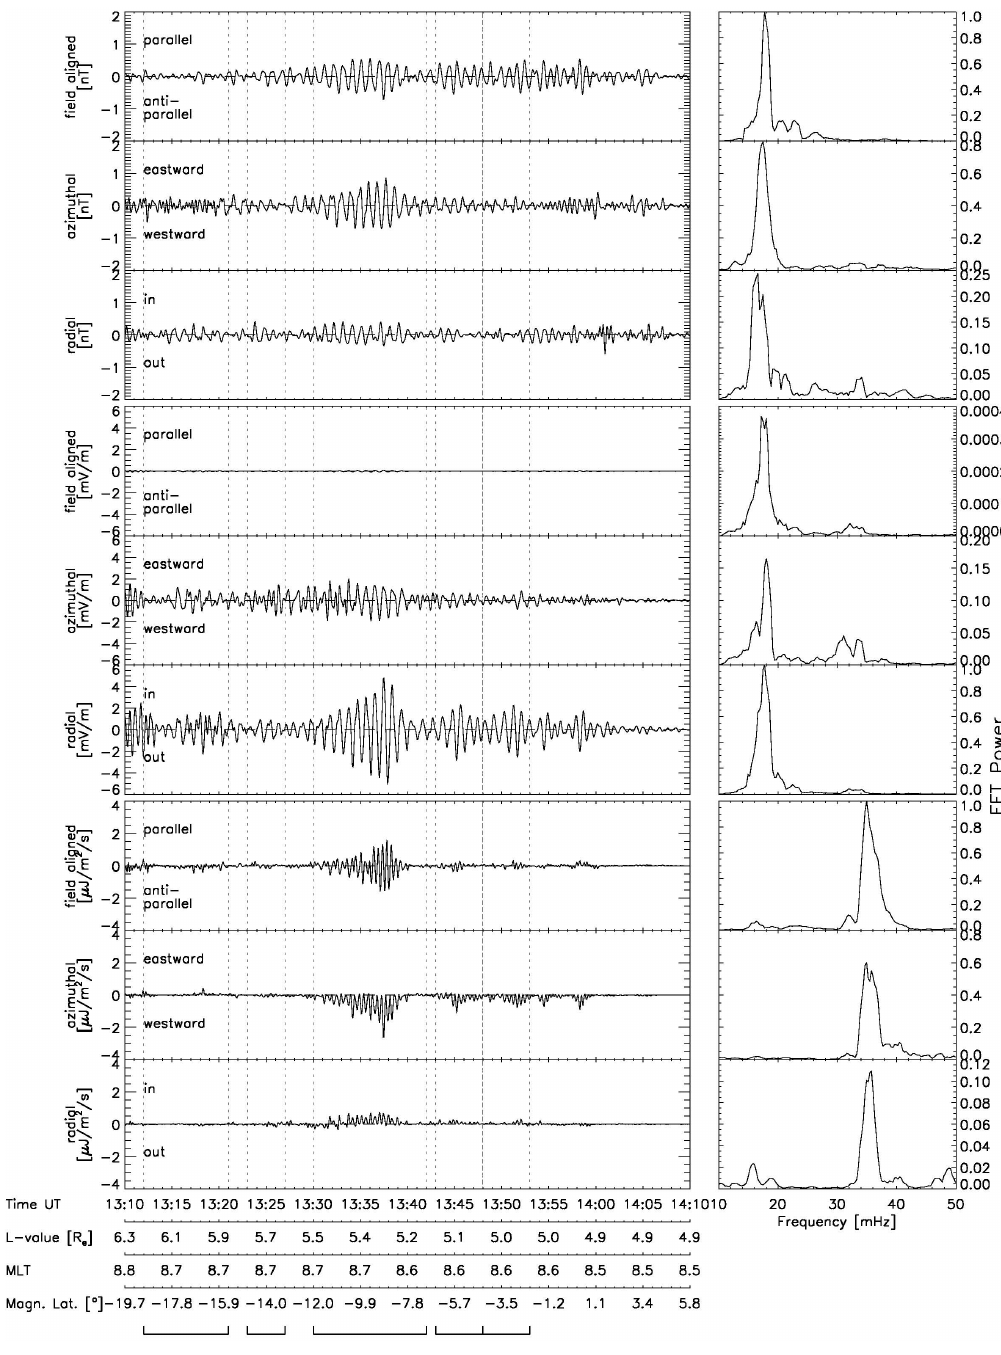
Fig. 4. Summary of field data from Cluster 4, same layout as Fig.